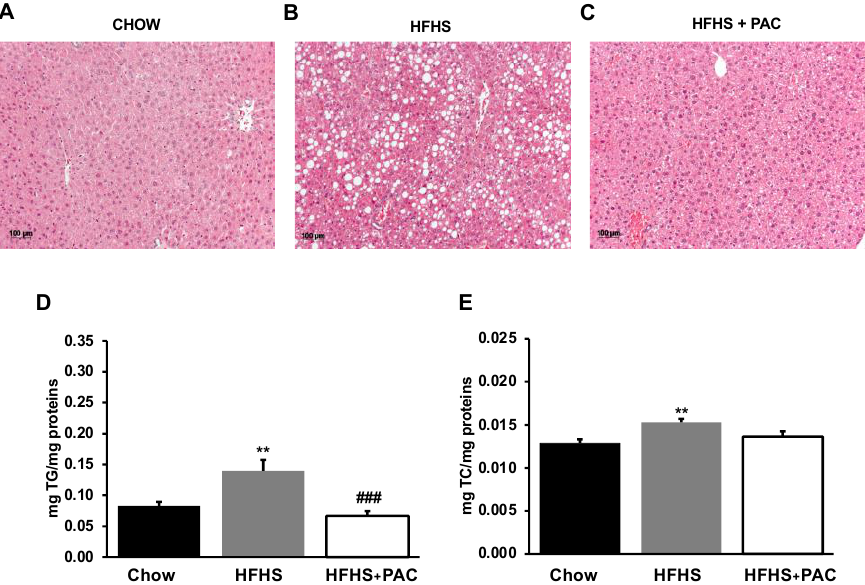
Figure 5. Effects of PAC on hepatic lipid accumulation. Representative images of hematoxylin phloxine saffron stained liver sections of ( A ) chow-, ( B ) high-fat, high-sucrose (HFHS) and ( C ) HFHS + PAC-fed mice for n = 4 mice/group; ( D ) Triglycerides and ( E ) total cholesterol content was quantified in liver tissue for n = 8 mice/group. Results are presented as mean ± SEM. ** p < 0.01 vs. chows; ### p < 0.001 vs. HFHS